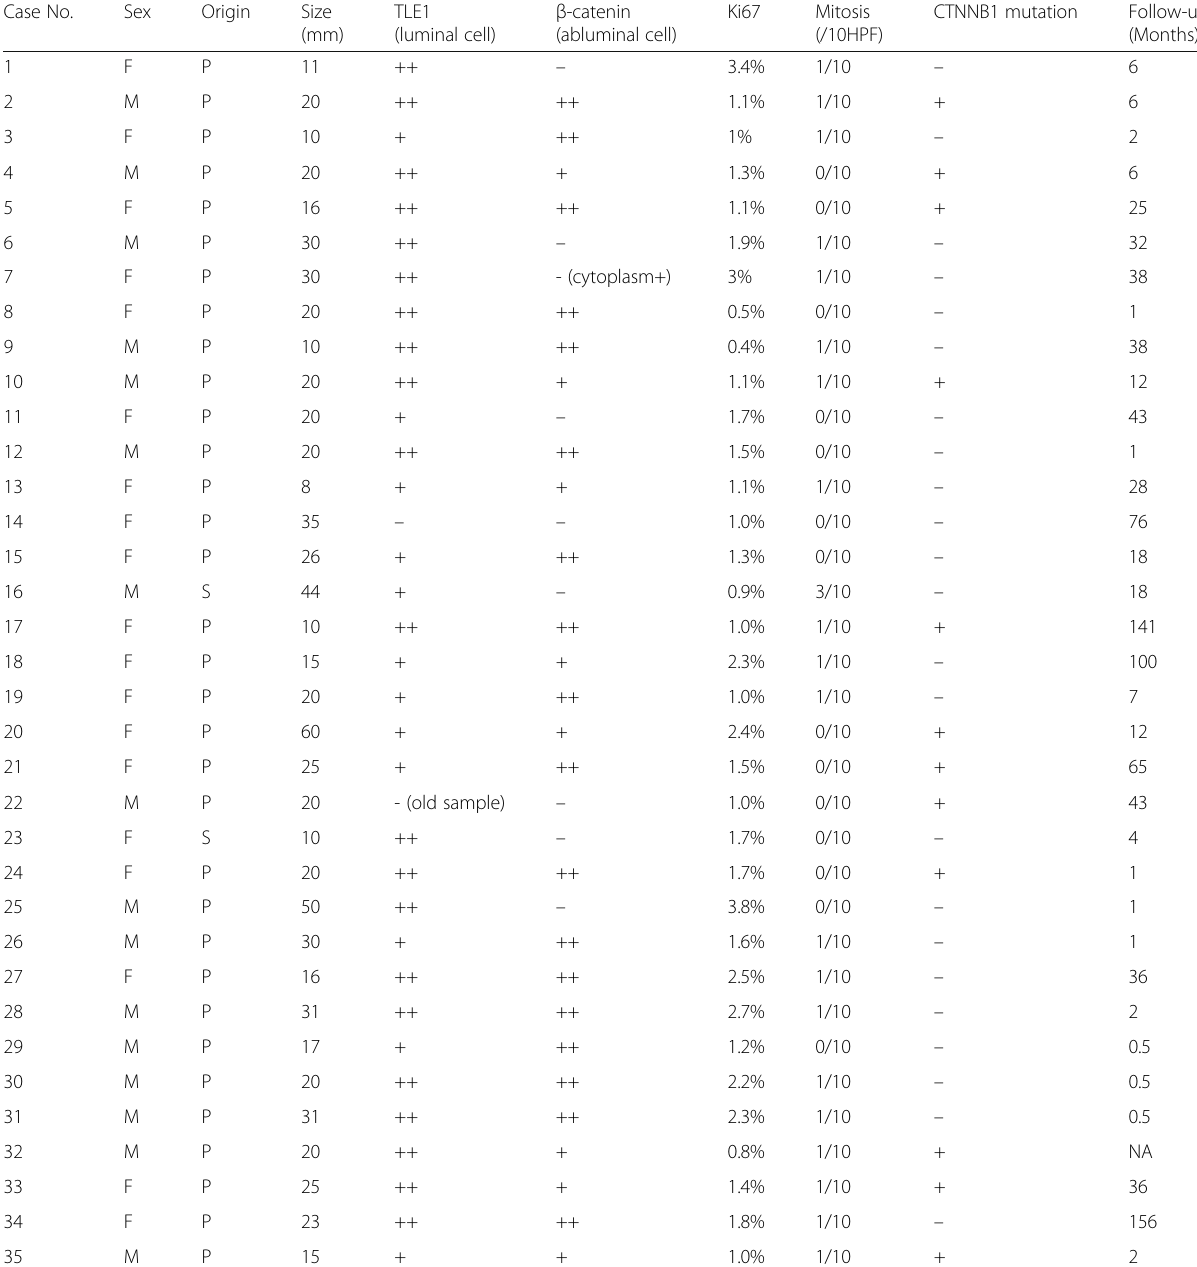
Table 1 Clinicopathological information of the 35 basal cell adenoma cases Case